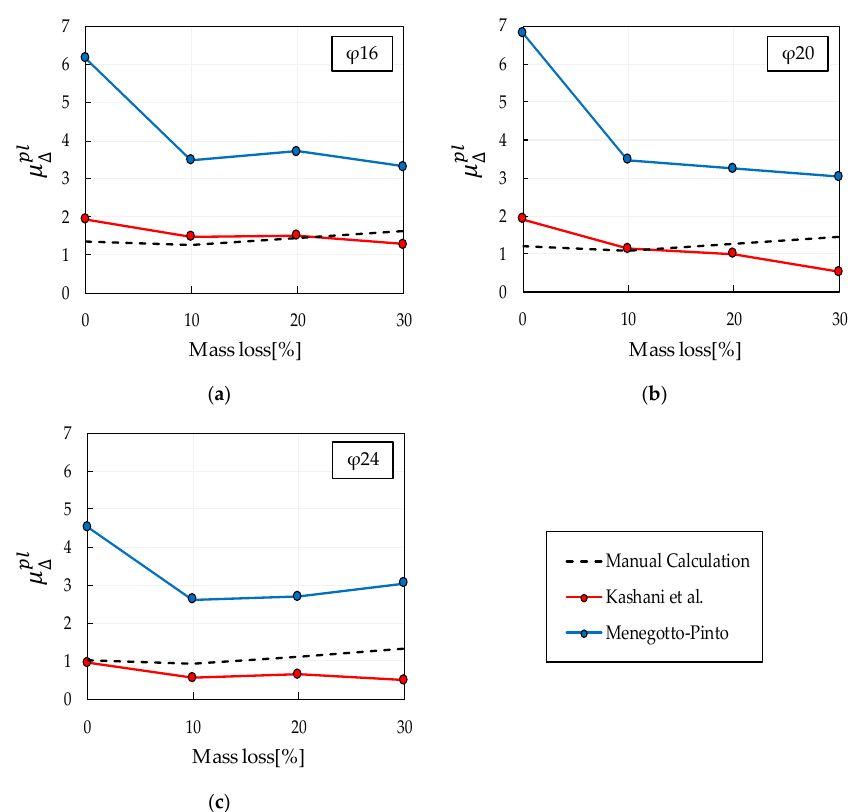
Figure 12. Ductility factors obtained from analytical calculation and NLFEA for different corrosion levels: ( a ) column φ16, ( b ) column 20, and ( c ) column φ24.